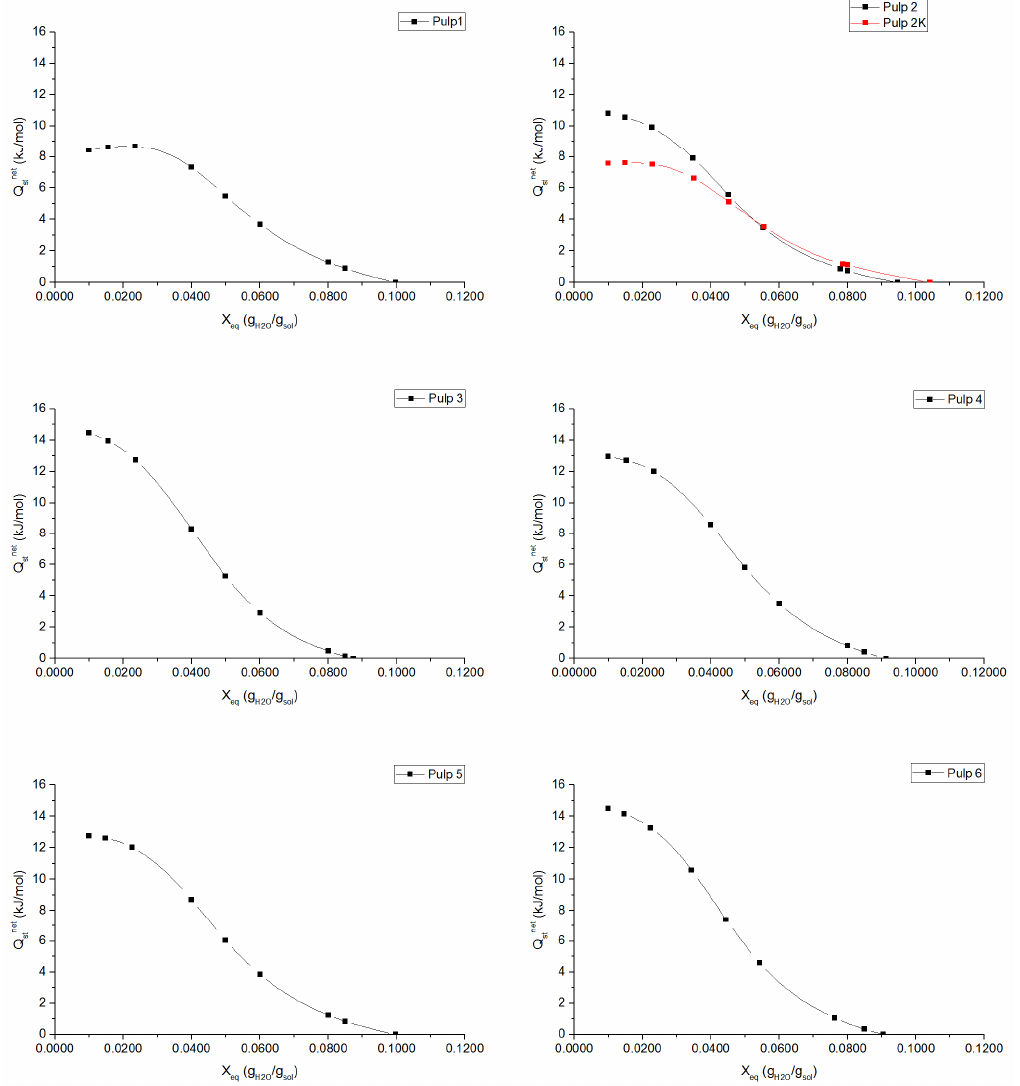
Figure 3. Net isosteric heat of sorption as function of moisture content derived from experimental sorption data for each pulp.